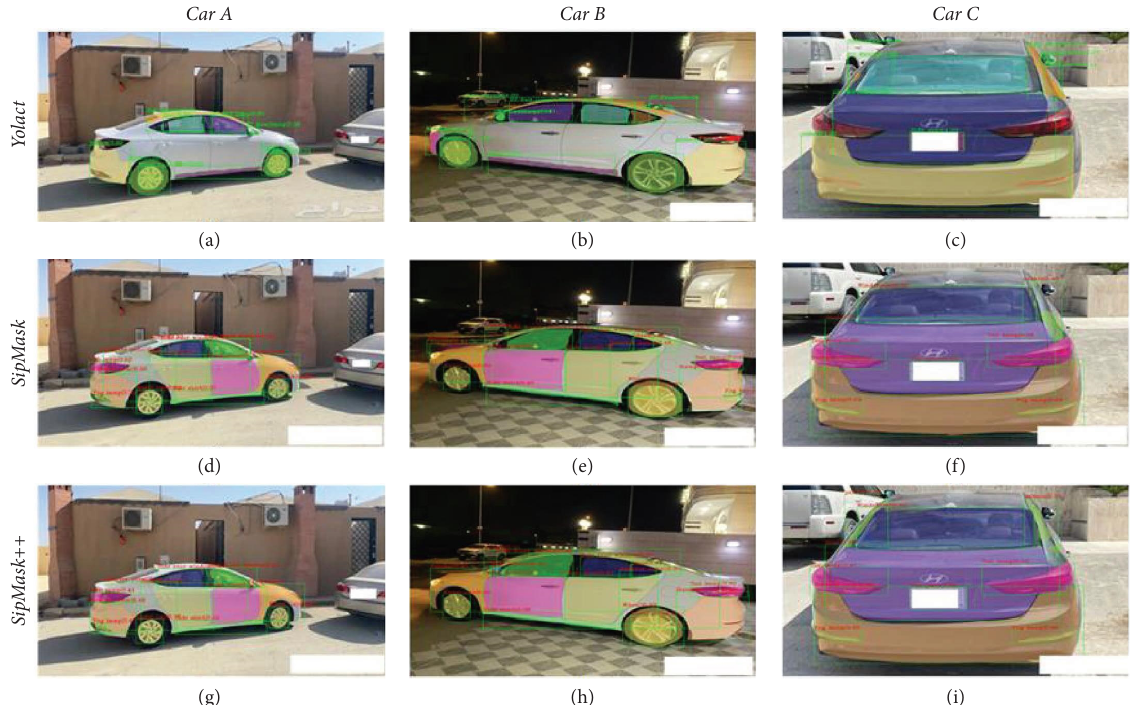
Figure 11: Comparing YOLACTto SipMask/SipMask++ instance segmentation regimes on a merged-classes (22) dataset with an increased sample size and augmentation modules: (a–c) YOLACT, (d–f) SipMask, and (g–i)